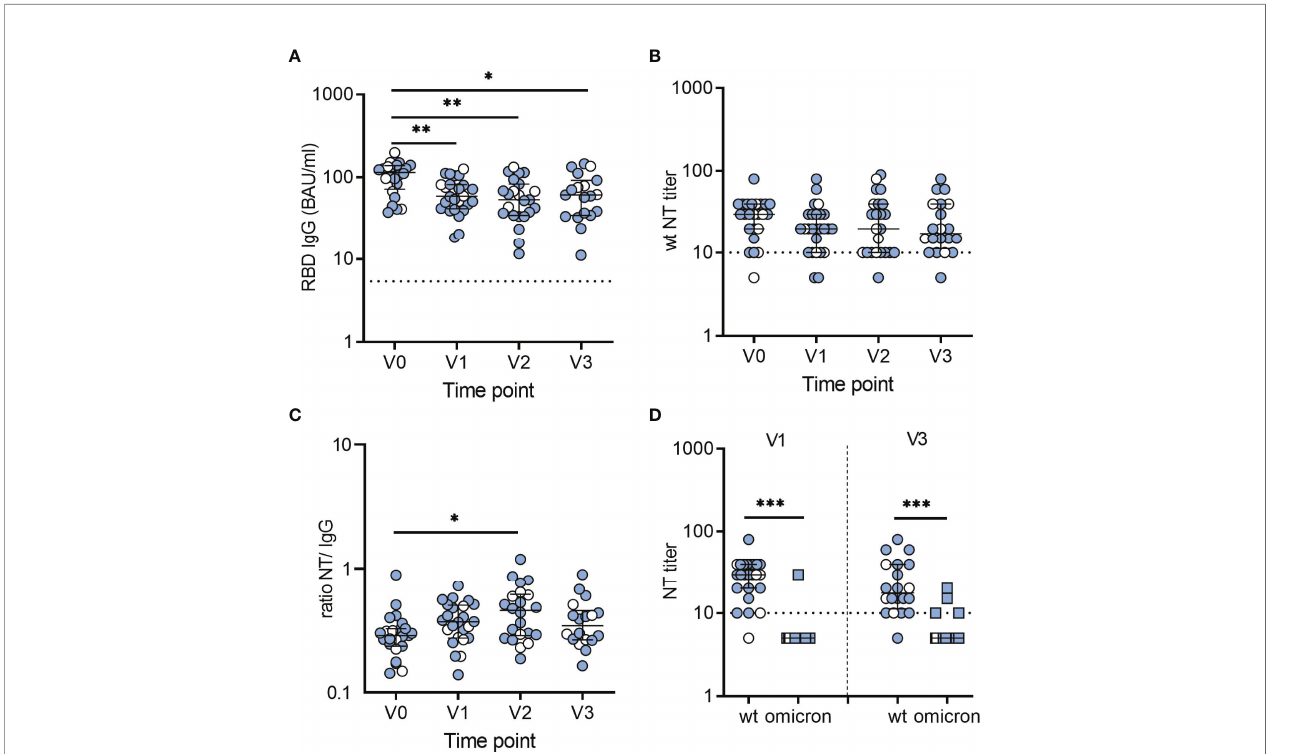
FIGURE 1 | Dynamics and levels of SARS-CoV-2-speci fi c antibodies after infection in children. (A) RBD-speci fi c IgG antibodies in BAU/ml. (B) Neutralizing antibody titers against an early pandemic virus strain (wildtype, wt). (C) Ratios of wt-neutralizing antibody titers and RBD-speci fi c IgG levels. Data for ratios include only samples with a positive result in neutralization assays. Time point V0 represents samples obtained at serodiagnosis; V1, V2, and V3 are follow-up samples obtained 6, 9 and 12 months after serodiagnosis, respectively. (D) NT titers against wt and omicron obtained 6 (V1) and 12 months (V3) after serodiagnosis. Bars represent median ± IQR. Blue symbols, symptomatic infection; white symbols, asymptomatic infection. The dashed line indicates the cut-off of the assays. Groups were compared with Kruskal-Wallis test and Dunn´s multiple comparison test (*P < 0.05; **P < 0.01; ***P <